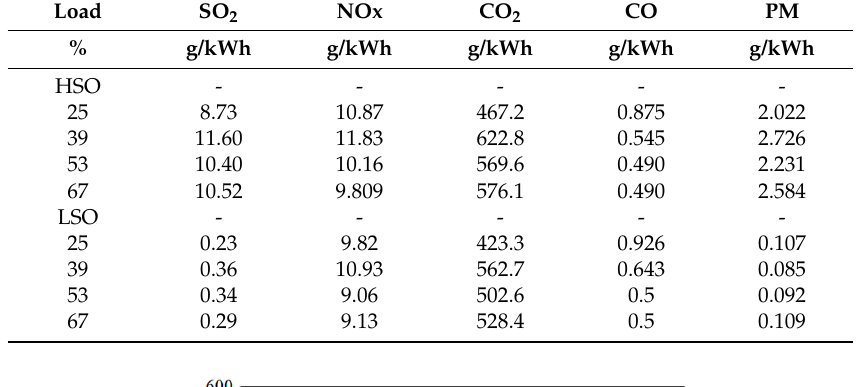
Table 3. Emission factors of different gases for the main engine.